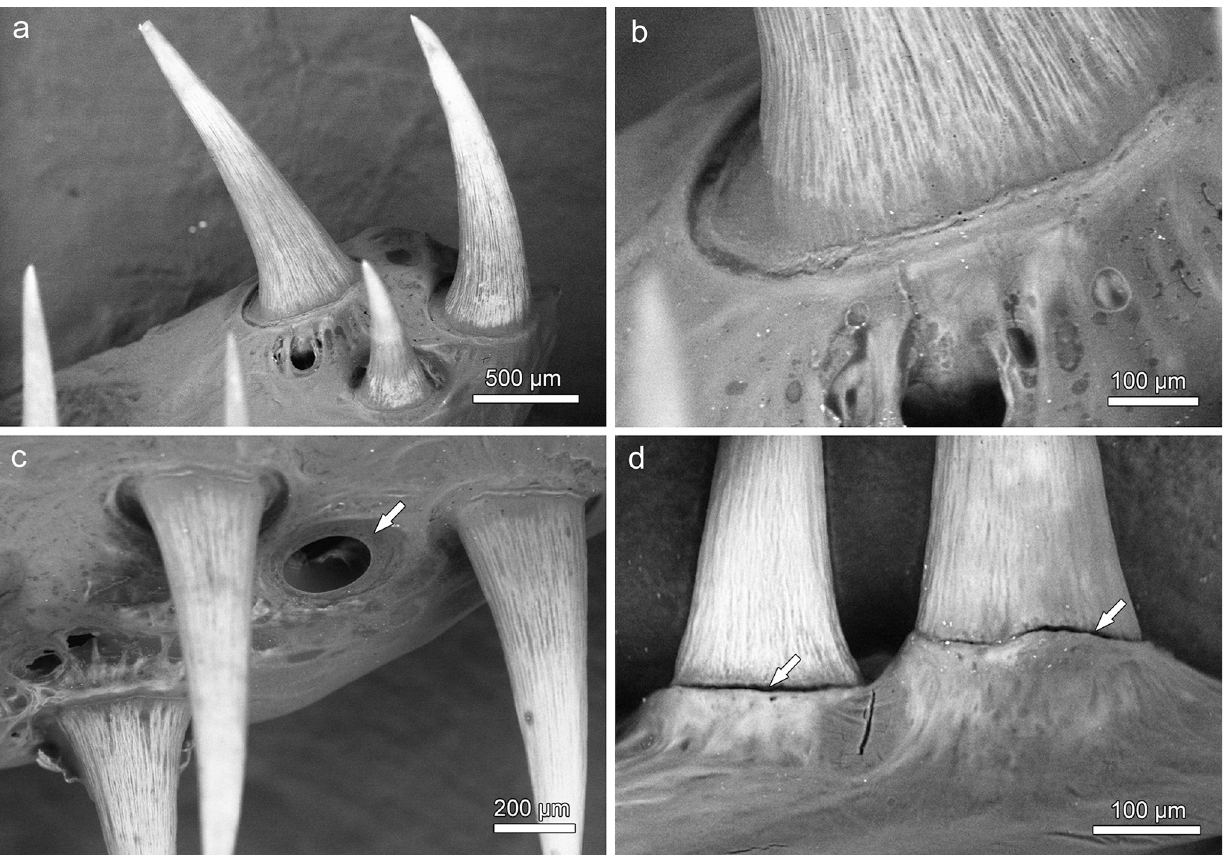
Fig 11. SEM-BSE images of tooth-bearing bones in the dorsal oropharynx of Anoplogaster cornuta , macerated specimen, anterior to left of images. (a) Teeth from the right ectopterygoid. The small tooth is regarded as a recently established replacement tooth. (b) Detail of a tooth base on the right ectopterygoid. The tooth is slightly lowered into the underlying bone cavity. (c) Teeth on the left entopterygoid. Note empty tooth position (arrow) with ring-like collagenous attachment structure still in place. (d) Pharyngeal teeth on the right dermopalatine attached to a bony socket. Note narrow clefts (arrows) previously occupied by a collagenous attachment